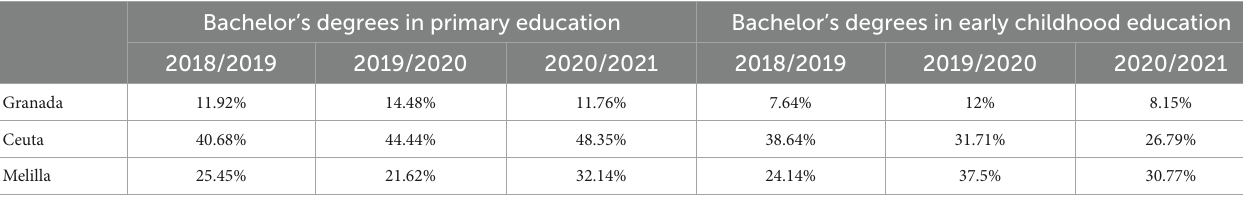
TABLE 2 Drop-out rates in primary education and early childhood education degrees at the University of